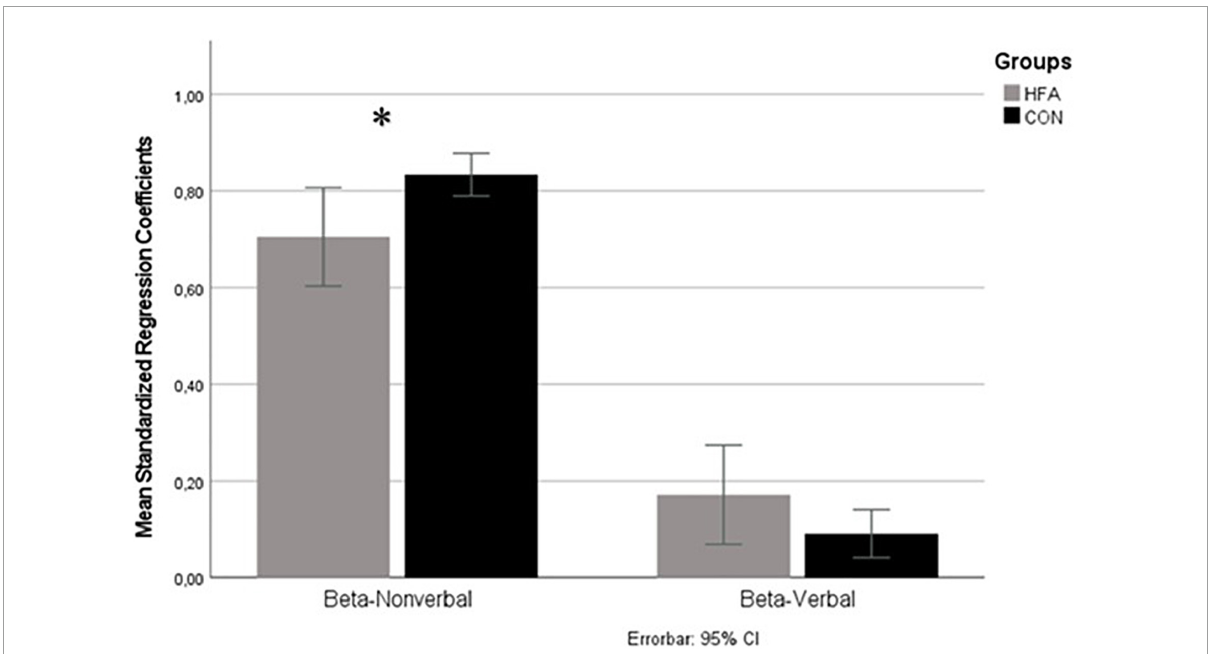
FIGURE1 Standardized regression coefficients quantifying the impact of nonverbal (beta-nonverbal) and verbal (beta-verbal) cues on rating of affective states. Means of Beta-coefficients of regression analysis on the y -axis, sources of information (verbal and nonverbal) on x -axis. Gray column represents high-functioning autism (HFA) group, black column typically developed control group. Errorbars indicate 95%-confidence interval. Significant differences are indicated by asterisks (level of significance ∗ < 0.05). A significant difference in the nonverbal condition was found, with a reduced impact of nonverbal cues in the HFA group as compared to the control group (CON) group. The difference in the impact of verbal cues showed a tendency to weight these more strongly in the HFA group at trend